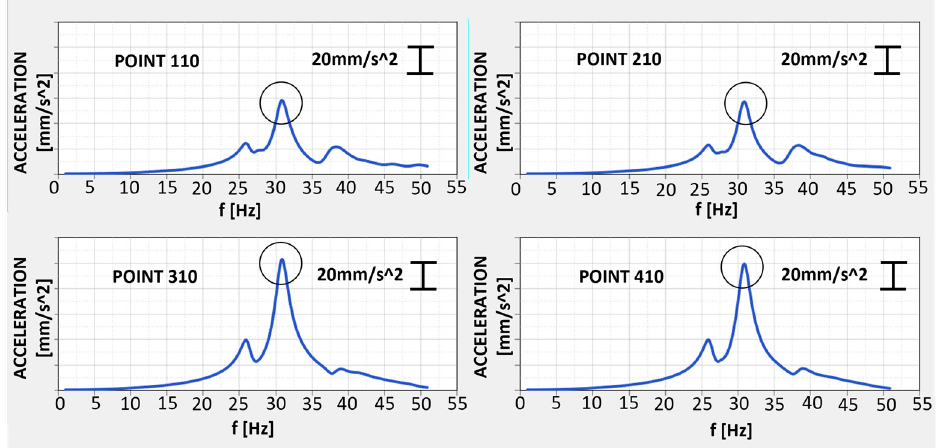
Figure 19. Acceleration vs. frequency on the four suspension attachment points of the new TB optimized model.